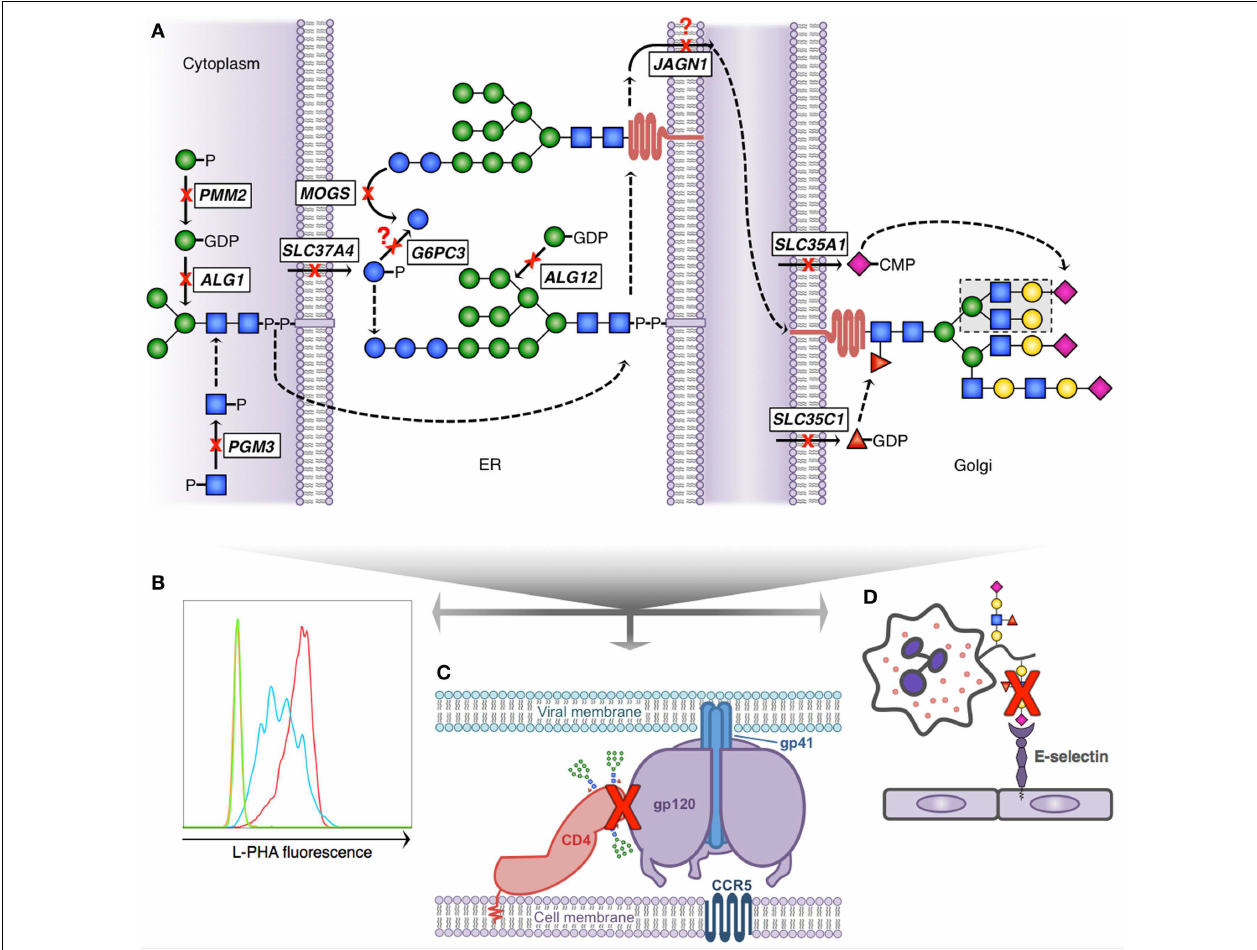
FIGURE 2 | Glycosylation pathway defects with known immunologic consequences . (A) Simplified scheme demonstrating N-linked glycosylation and 10 known gene defects resulting in altered glycosylation and immunologic disease; dashed arrows indicate presence of non-depicted enzymatic steps; question marks depict theoretical blocks for which the mechanistic defect remains speculative. N -glycan formation begins in the cytoplasm (left) where phosphoglucomutase 3 ( PGM3 ) and phosphomannomutase 2 ( PMM2 ) provide key sugar substrate and beta-1,4-mannosyltransferase ( ALG1 ) adds the first mannose. The core glycan is transferred to the ER lumen where